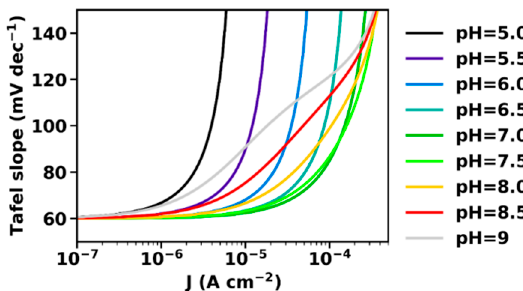
Figure 3. Tafel slopes at various pH, calculated according to the derivative of Equation (20). At low current densities at all investigated pH the Tafel slope is close to the “classical” value of 60 mV dec − 1 , while at high current densities it increases due to proton transport limitations. The parameters used for simulation are the same also used in Figure 2: α ET = 1, k D = 10 mA cm mol − 1 , B 0 = 0.1 M, pK aB = 7, J e0 = 10 − 12 A cm − 2 .